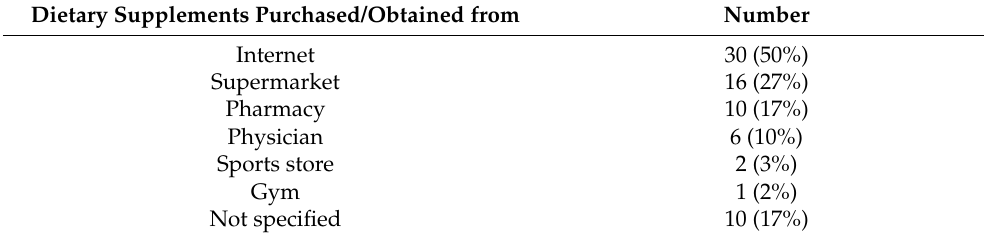
Table 2. Replies to the question of where dietary supplements are purchased/obtained from, multiple replies were possible, n = 60.